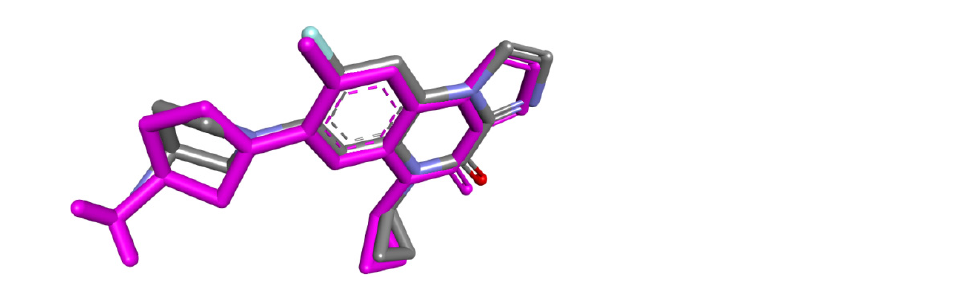
Figure 3. Overlying of real (grey-colored) and predicted position (pink-colored) of the ligand E32 (RMSD = 1.09) DNA gyrase (PDB code: 6FQM).